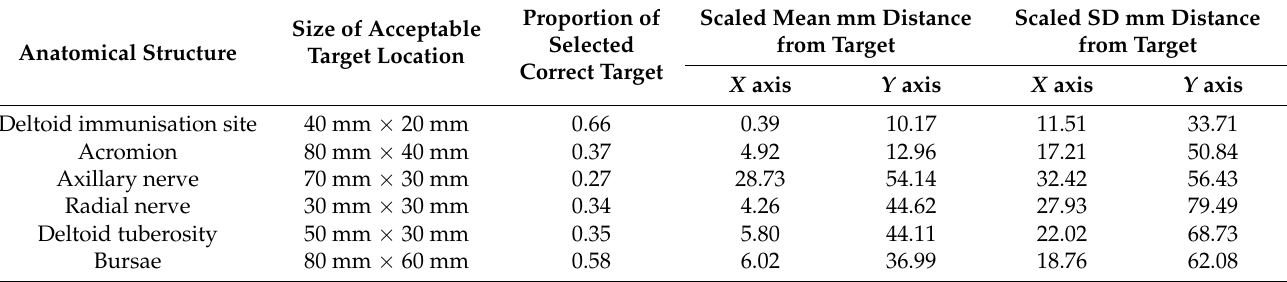
Table 3. Accuracy of anatomical knowledge on a model image.